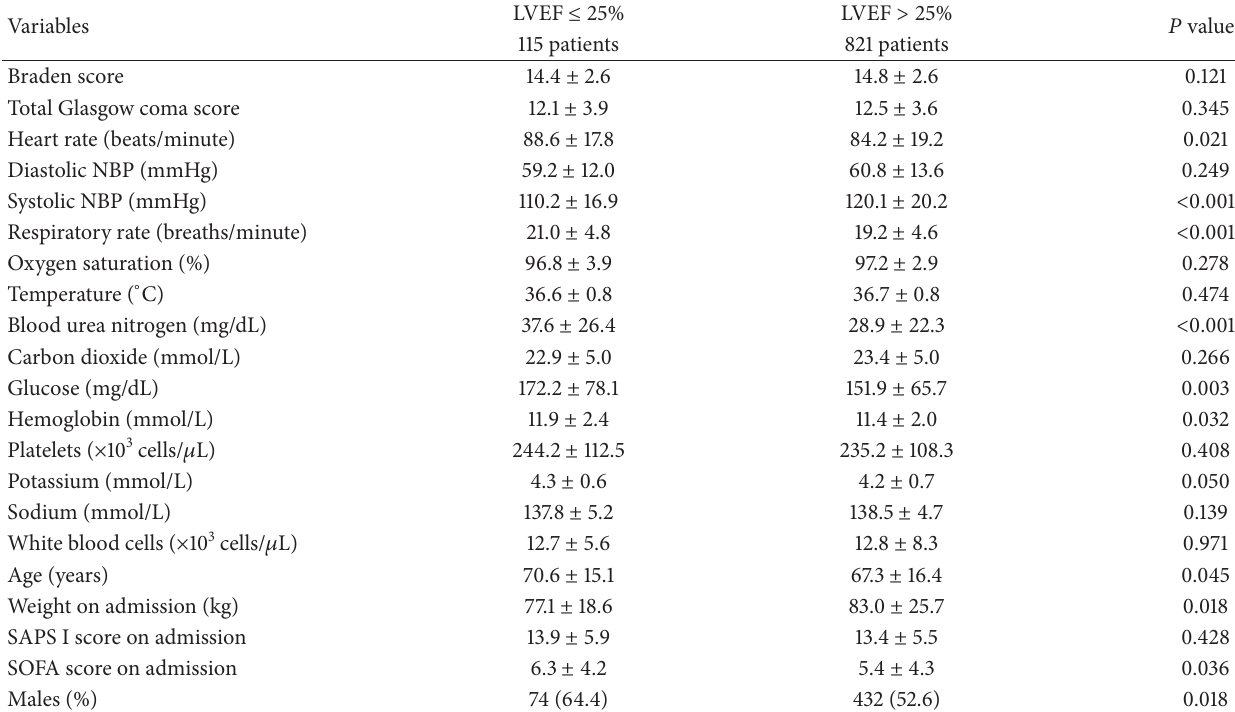
Table 1: Baseline demographic and clinical characteristics within the first 6 hours of ICU admission in the cohort regarding patients with LVEF ≤ 25% and LVEF > 25%.